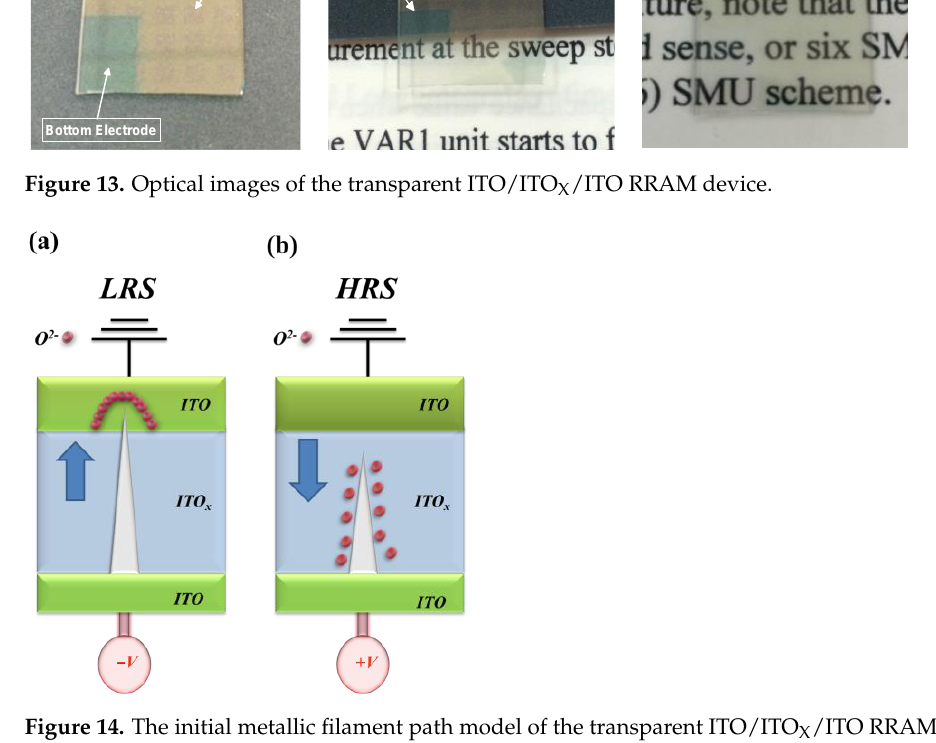
Figure 14. The initial metallic filament path model of the transparent ITO/ITO X /ITO RRAM device for ( a ) LRS (set), and ( b ) HRS (reset) state.